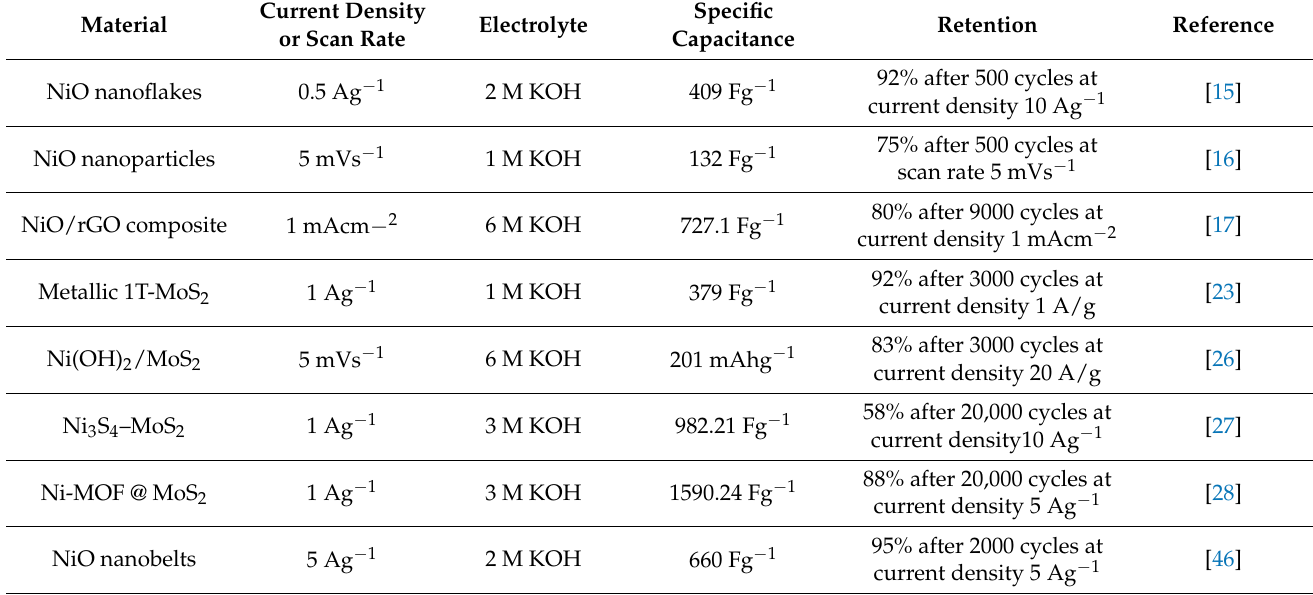
Figure 7. Growth mechanism and charge storage reaction at the electrode and electrolyte surface. Table 1. Specific capacitance comparing similar work and carbon-based electrode